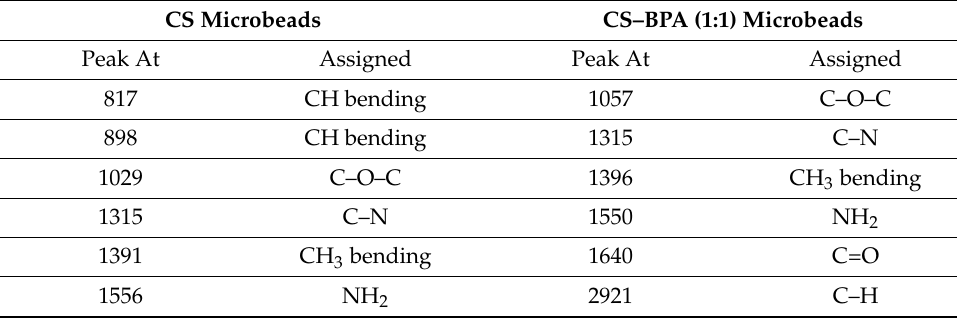
Table 2. Peak data for CS and CS–BPA (1:1)